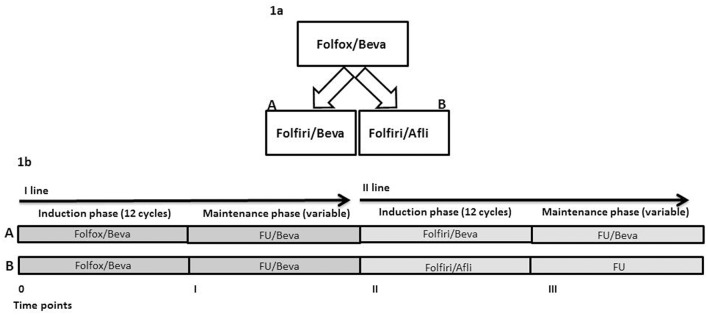
(A) Study design. (B) Schematic representation of study time points.